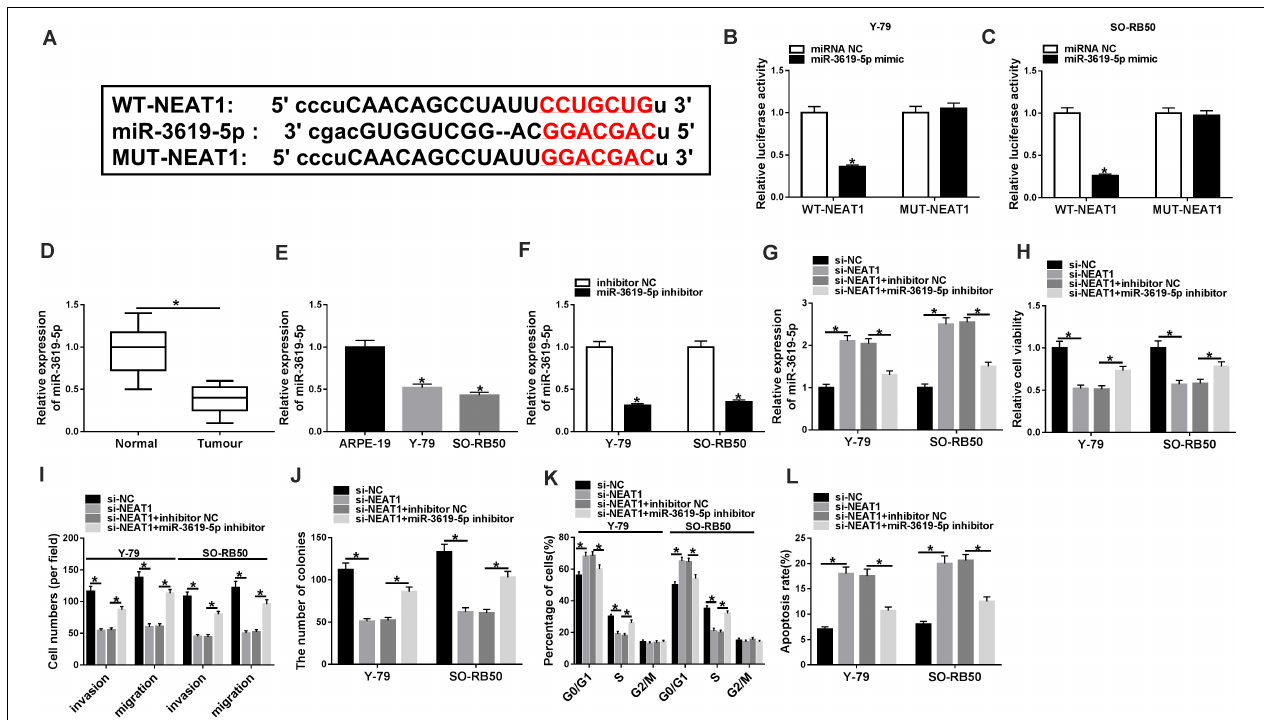
FIGURE 3 | MiR-3619-5p inhibitor partially reversed the effects of NEAT1 knockdown on RB progression. (A) The binding sequence of miR-3619-5p in NEAT1 was predicted by starBase 3.0 database. (B,C) Dual-luciferase reporter assay detected luciferase activities in Y-79 and SO-RB50 cells. (D,E) MiR-3619-5p expression was determined by qRT-PCR in RB tissues and cells. (F) The silencing efficiency of miR-3619-5p inhibitor was determined by qRT-PCR. (G) The effects between NEAT1 knockdown and miR-3619-5p inhibitor on miR-3619-5p expression in Y-79 and SO-RB50 cells were detected by qRT-PCR. (H,J) The cell proliferation was detected by CCK-8 and cell formation colony assay in Y-79 and SO-RB50 cells. (I) Transwell assay detected the migration and invasion of Y-79 and SO-RB50 cells. (K,L) Flow cytometry assay accessed the effects between NEAT1 knockdown and miR-3619-5p inhibitor on cell cycle and apoptosis. * P <